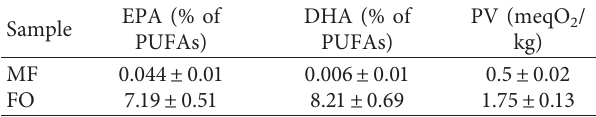
Table 2: Characterization of milk fat and fish oil